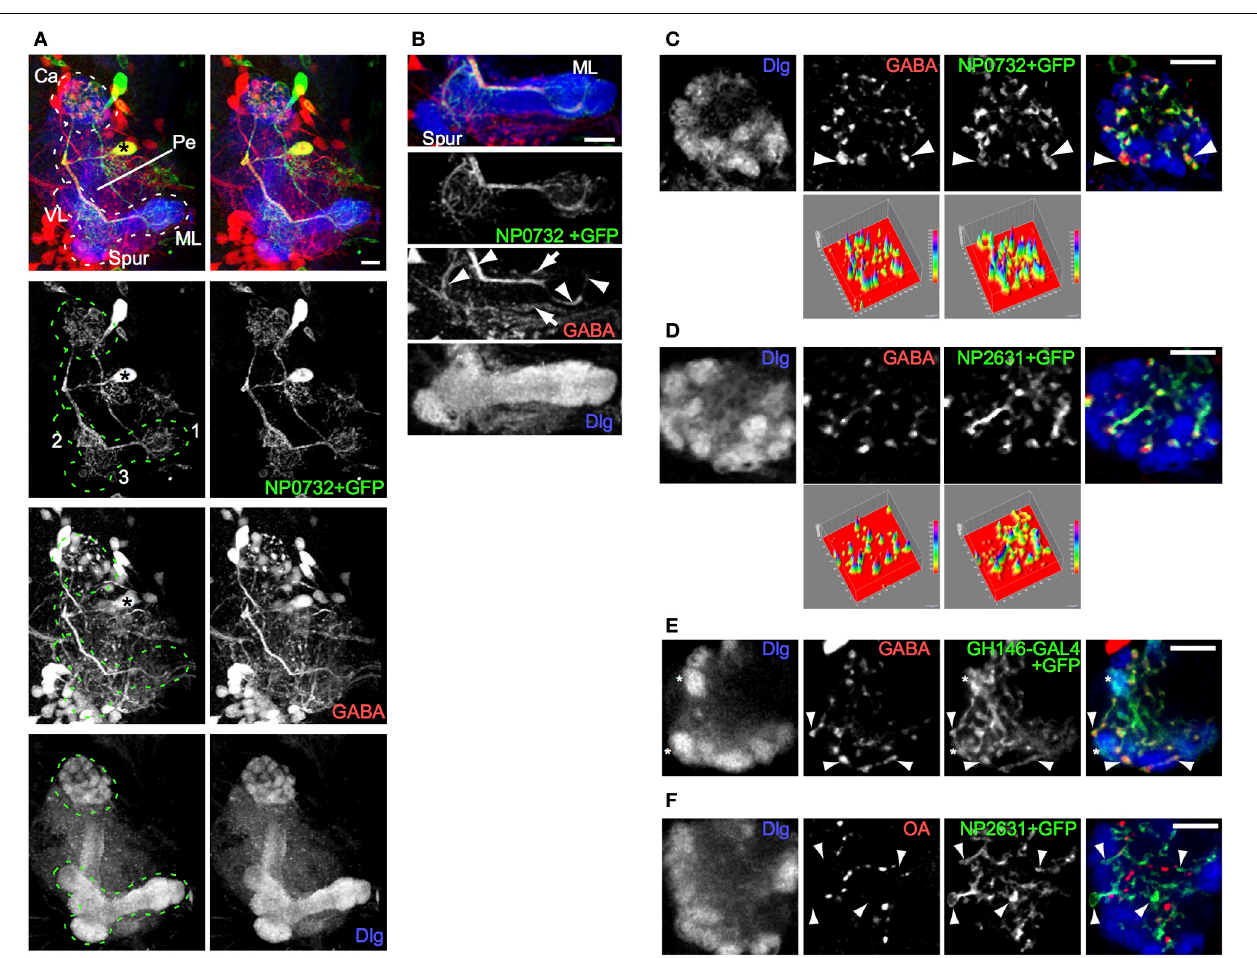
FIGURE 1 | A single larval GABAergic neuron, resembling the adult APL neuron, innervates the larval calyx. (A) NP0732-GAL4 expression, visualized using UAS-mCD8::GFP, is seen in two large cell bodies, in a stereo image of an anterior view of a 3D reconstruction of the larval central brain. One of these (asterisk) posterior to the MB sends a neurite laterally, which branches upwards to the MB calyx (Ca) and downwards to arborizations (labeled in the GFP channel) in (1) the terminal regions of the medial lobe (ML), (2) the proximal region of the vertical lobe (VL), and (3) an area in the region connecting the lower pedunculus (Pe) and vertical lobe. The MB is labeled using anti-Dlg. (B) A projection of four confocal sections through the medial lobe of the same preparation. GABA is found in the NP0732-GAL4 neuron (arrowheads), although weakly and sporadically in its fine arborizations, as well as in one or more neurons innervating the lobes that are not labeled by NP0732-GAL4 (arrows) (C) Confocal section of a larval calyx, showing numerous GABAergic